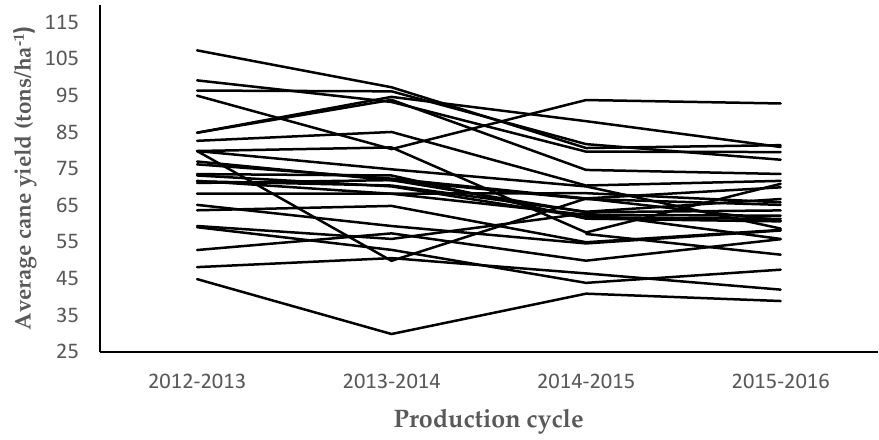
Figure 1. Average cane yield per production cycle of 26 sugarcane varieties.